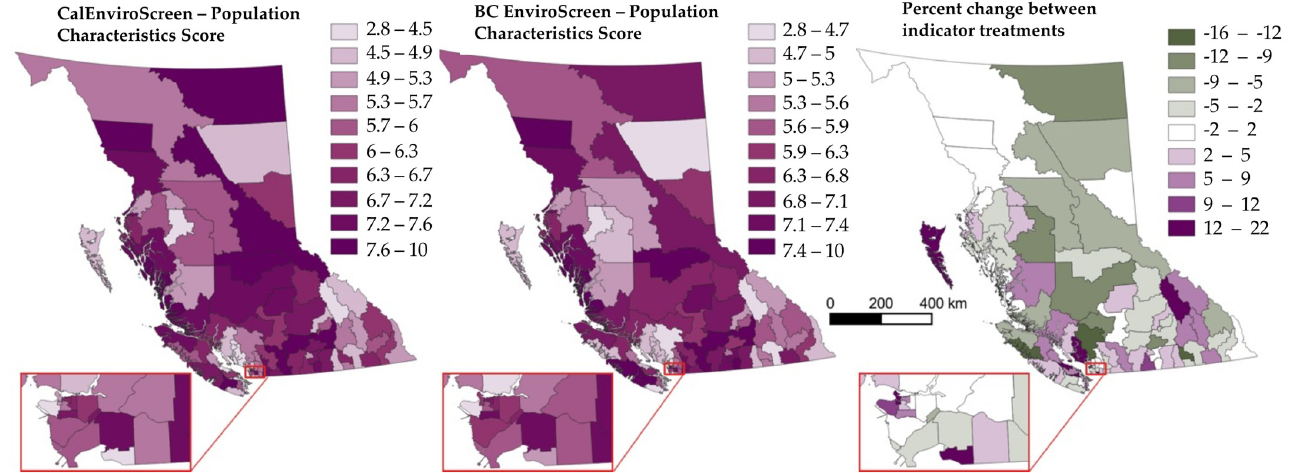
Figure 3. Comparing two treatments of EnviroScreen indicators on ‘population characteristics’ scores in British Columbia,